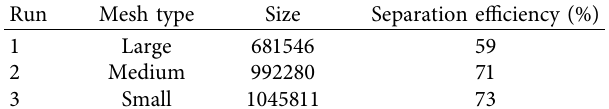
Table 3: Hydrocyclone separation efficiencies in different calcu- lation meshes.